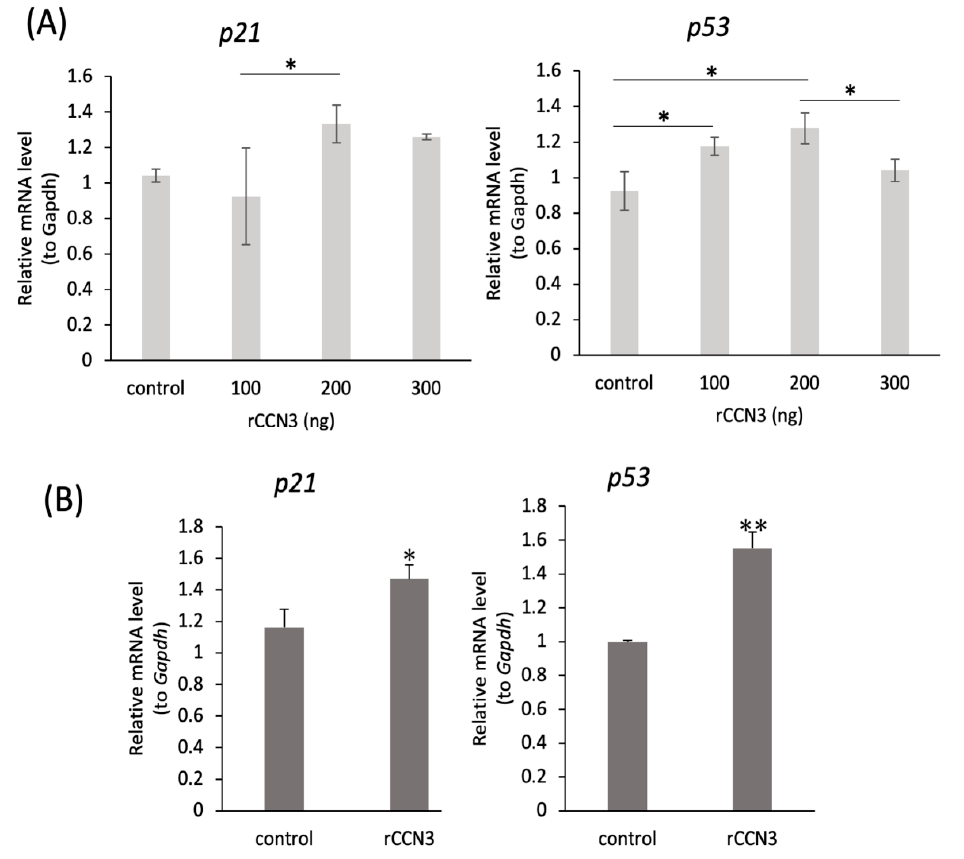
Figure 4. Stimulation of p21 and p53 mRNA expression by recombinant CCN3 treatment in ( A ) mouse primary articular chondrocytes from 2w knee joints and ( B ) RCS cells. Recombinant CCN3 was added to the media at indicated concentrations ( A ) and 100 µg/mL ( B ). Total RNA was harvested after 24 h incubation. The data represent the mean ± SD ( n = 5 individual cultures). * p < 0.05, ** p < 0.01.